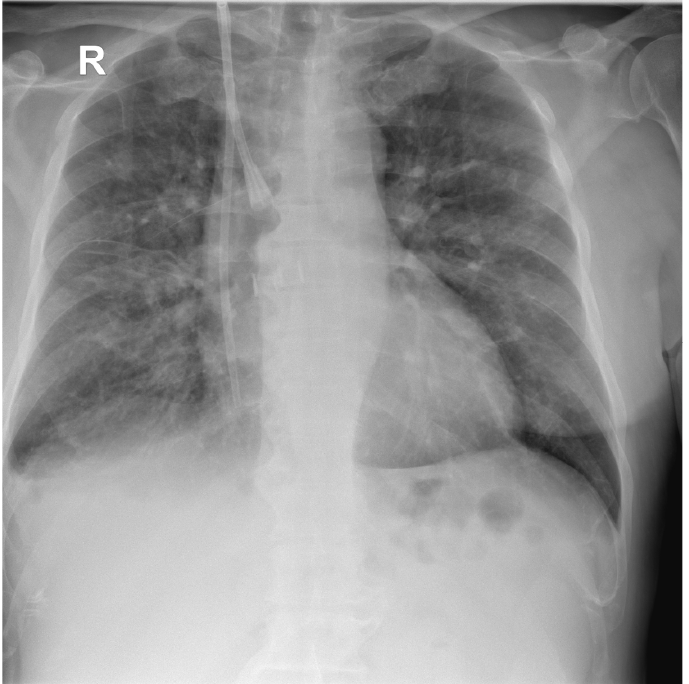
Figure 2. Postero-anterior chest X-ray of the first patient at hospital admission showing multiple hazy areas of mixed (alveolo-interstitial) infiltrates scattered throughout both lungs, and central venous catheter with insertion in the right internal jugular vein and internal end in the right atrium.